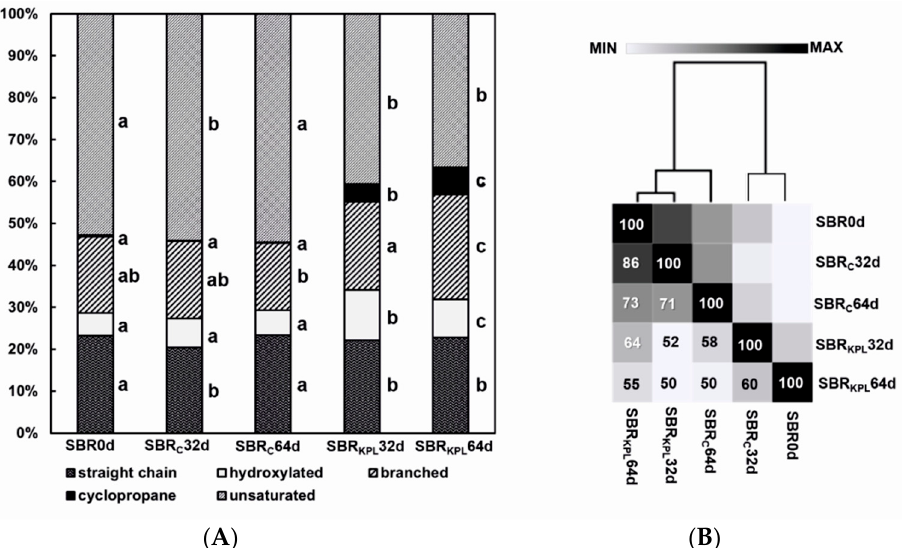
Figure 7. The percentages of distinct fatty acids isolated from the AS at the beginning (0d) and after 32 and 64 days of wastewater treatment in the SBR C and SBR KPL ( A ) and cluster display of the values of similarity coefficients (SIM) between the structure of microbial communities in the AS based on the FAME profile analysis ( B ).